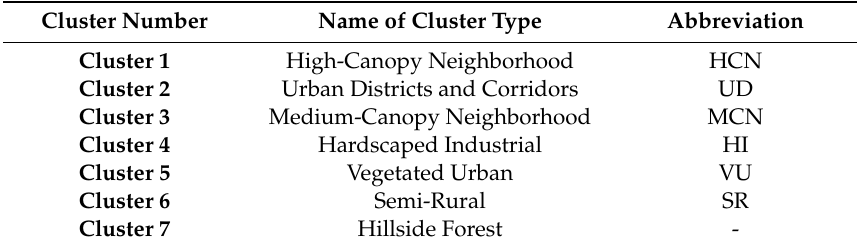
Table 1. Names and abbreviations of the seven cluster types used in microclimate modeling.